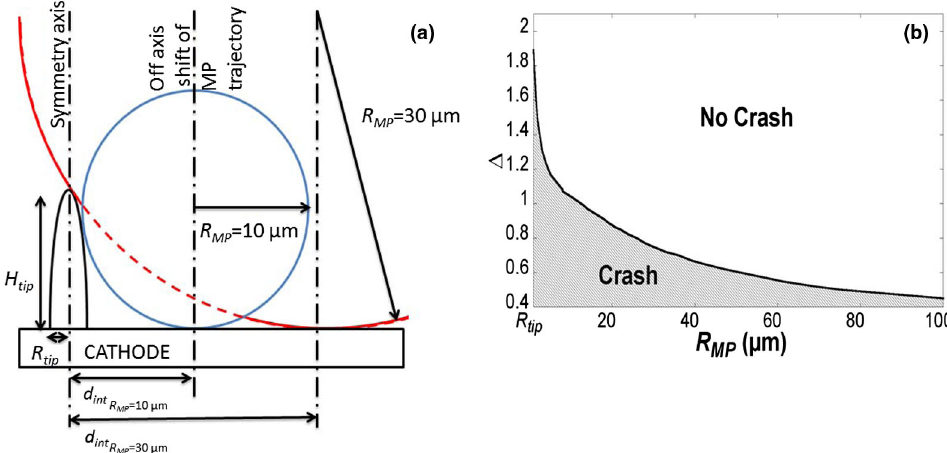
FIG. 15. (a) Sketch of the crash of a large MP touching the tip. (b) Off-axis study. Δ is a reduced parameter, related to the size of the tip ). divided by the MP radius ( Δ ¼ d int R MP